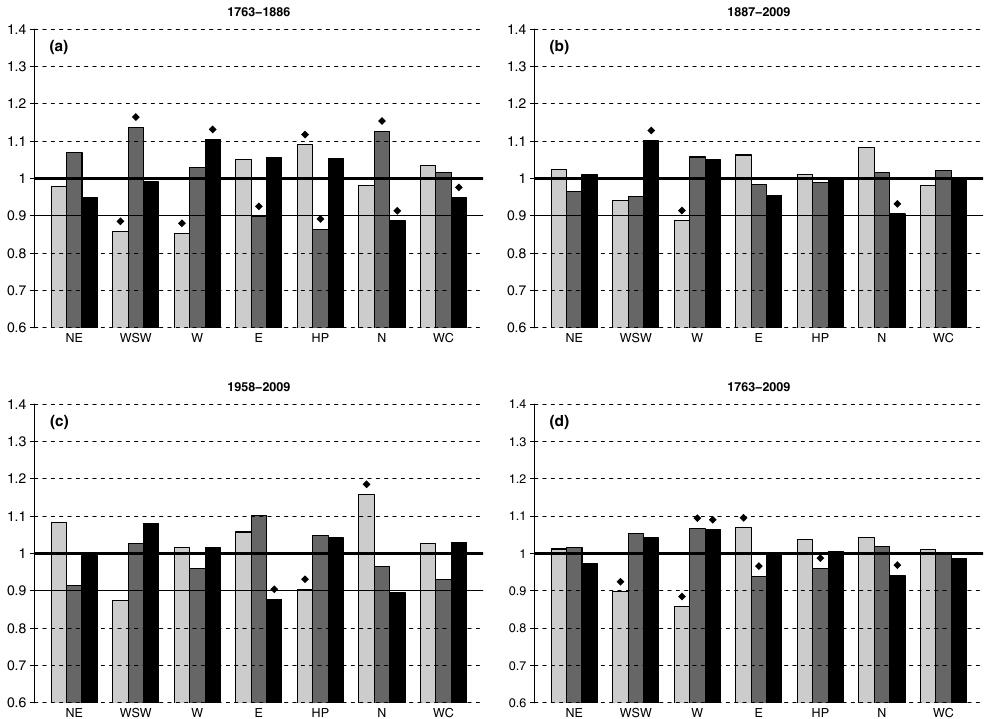
Figure 5. Ratios of the frequency for the low (light grey), moderate (grey), and high (black) solar activity classes relative to the long-term mean for different periods. Dots correspond to statistical significance of the ratios at the 95%